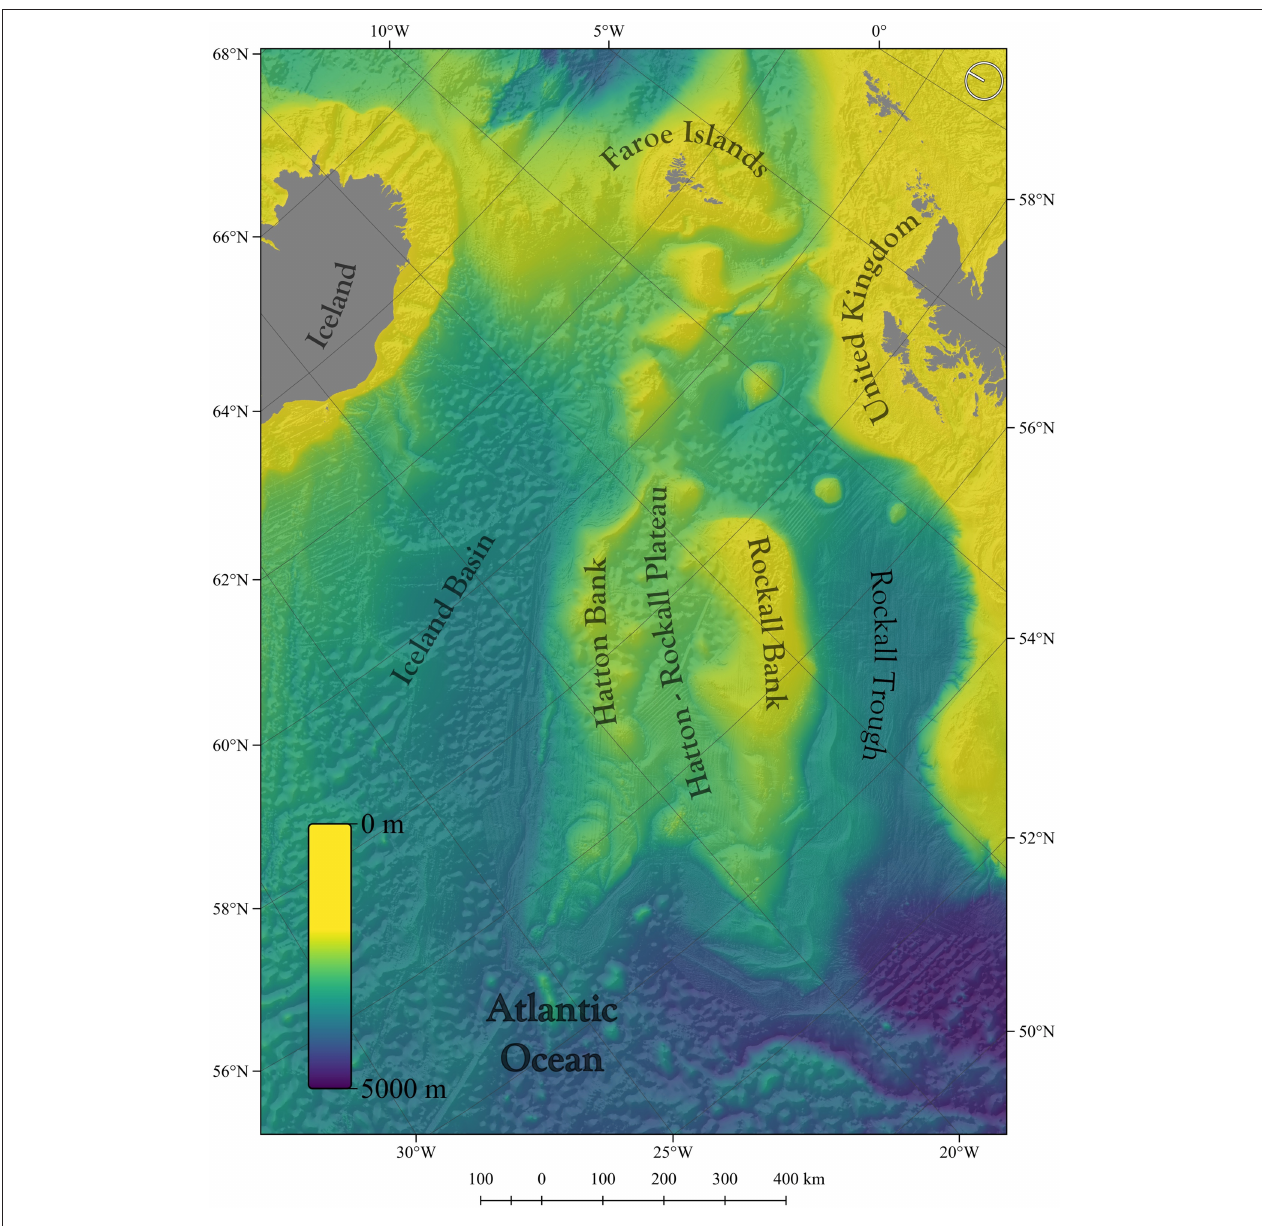
FIGURE 1 | The Hatton-Rockall